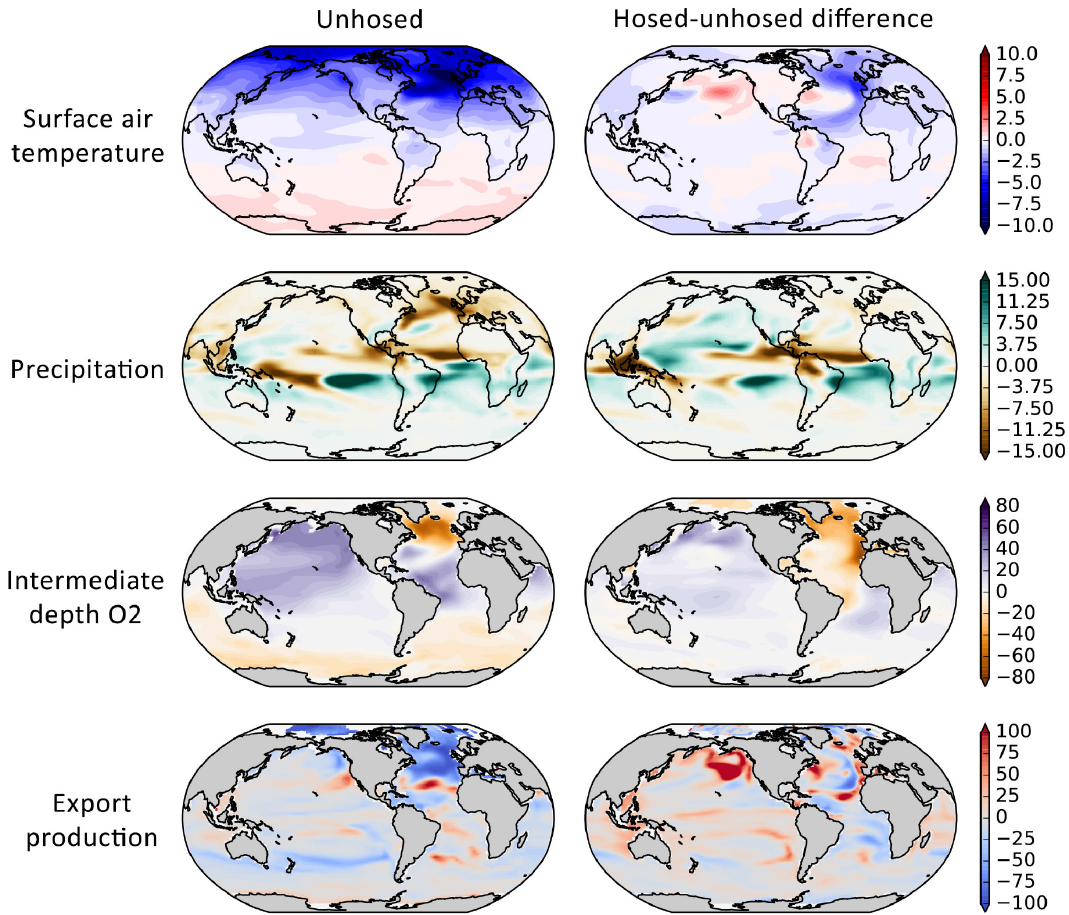
Figure 11. Impacts of hosing the unhosed. Left column: differences between weak and strong AMOC states for the unhosed simulation as shown in Figs. 6, 7, 8, and 9. Right column: differences between the last century (model years 6151–6250) of the 800-year hosed–unhosed stadial and the corresponding unhosed stadial. Scale and units are the same as in Figs. 6, 7, 8, and 9: temperature in ◦ C, precipitation in 10 − 6 kgm − 2 s − 1 , oxygen concentration in µmolkg − 1 , and export anomaly in